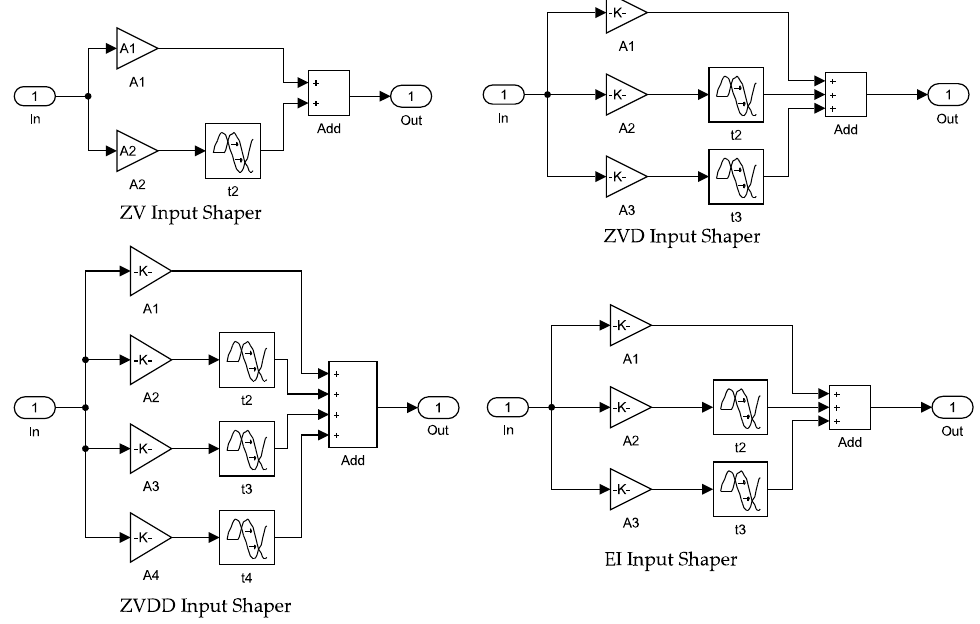
Figure 11. Input shaper module.